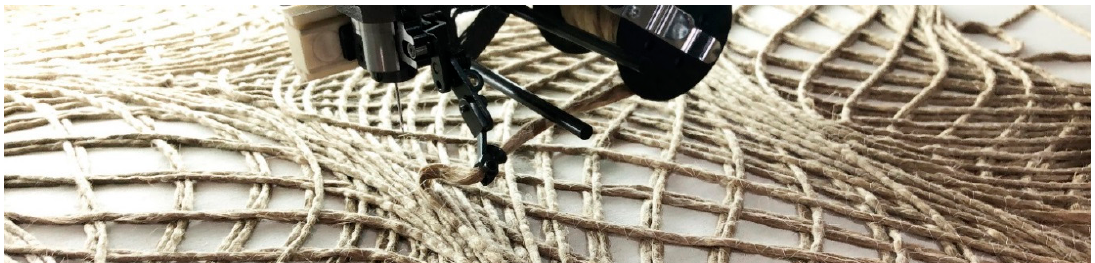
Figure 9. Tailored fiber placement process.